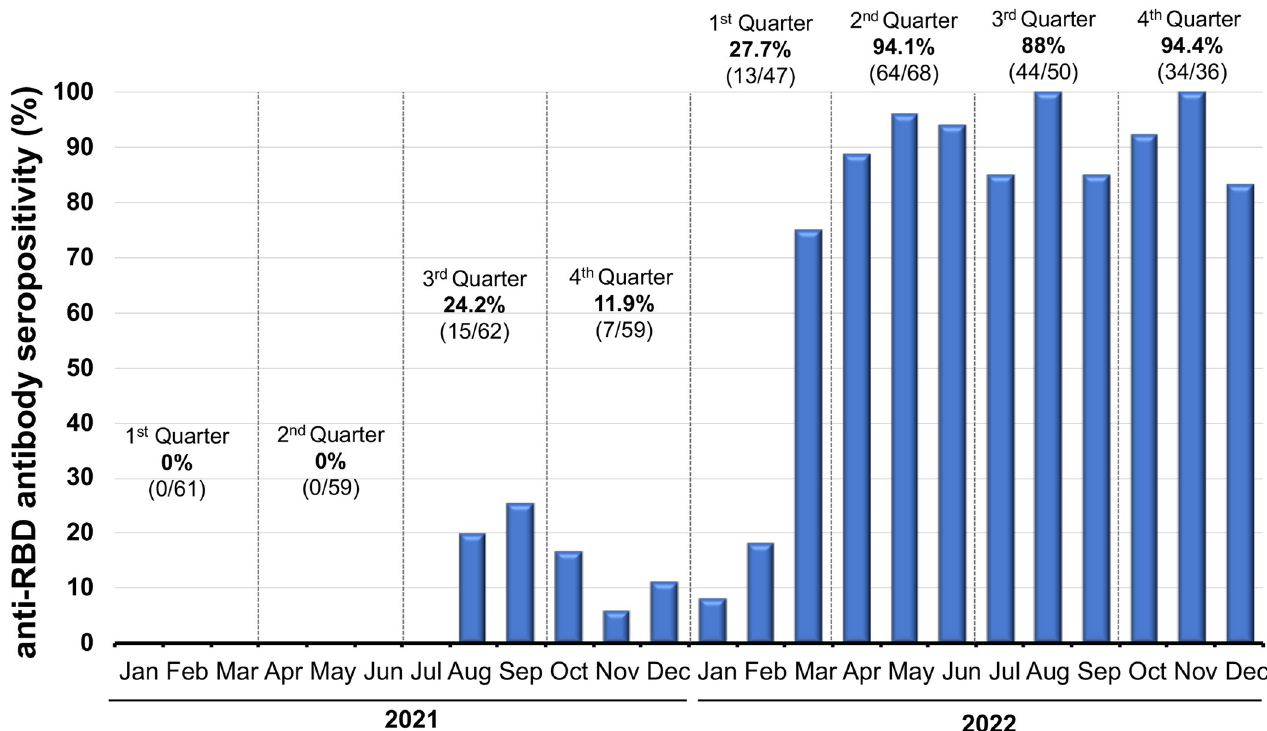
Fig 3. Monthly distribution of seroprevalence induced by infection, vaccination, and hybrid immunity observed in children aged 5–7 years old between January 2021 and December 2022. Seroprevalence induced by infection, vaccination, and hybrid immunity was estimated based on the anti-RBD antibody seropositivity in both unvaccinated and vaccinated